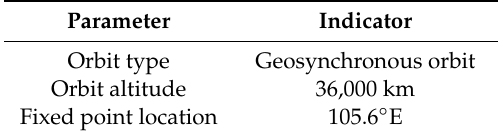
Table 1. Orbit parameters of the Gaofen-4 (GF-4) satellite.